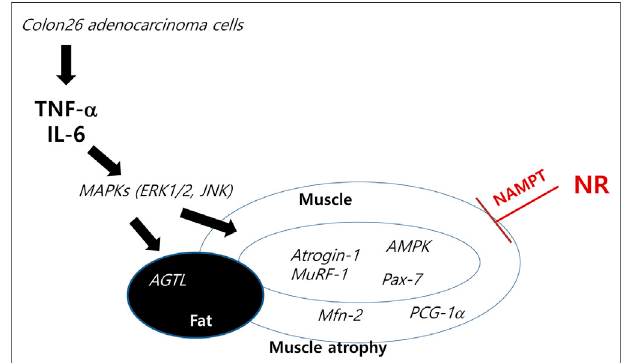
FIGURE 6 | Schematic presentation telling how NR intake tackles the cachexic process. Anti-cachexic effect of preemptive dietary intake of NR vitamin B3 in C26 adenocarcinoma – induced cancer cachexia. Preemptive administration of NR exerted signi fi cant protection from muscle atrophy, in fl ammation, and catabolic disaster featured in cancer